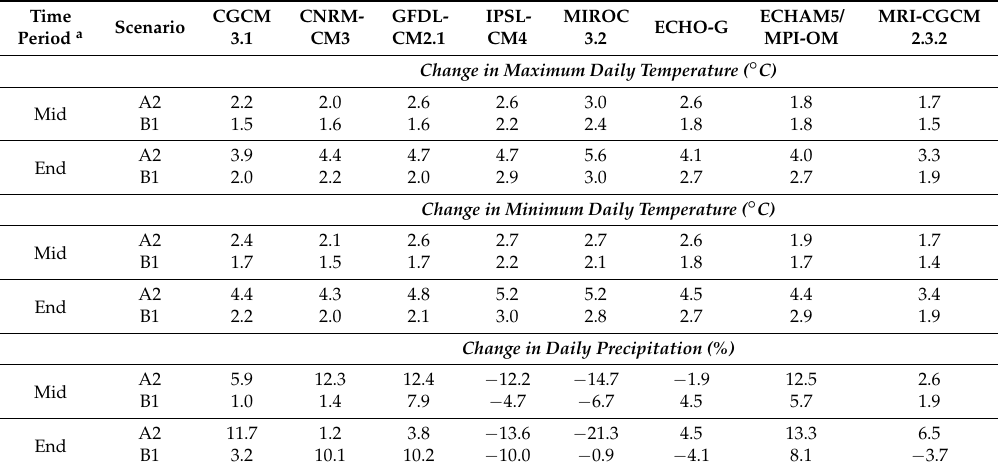
Table 2. Changes in daily average temperature ( ◦ C) and precipitation (%) over the next century as modeled by the eight GCMs used in this study